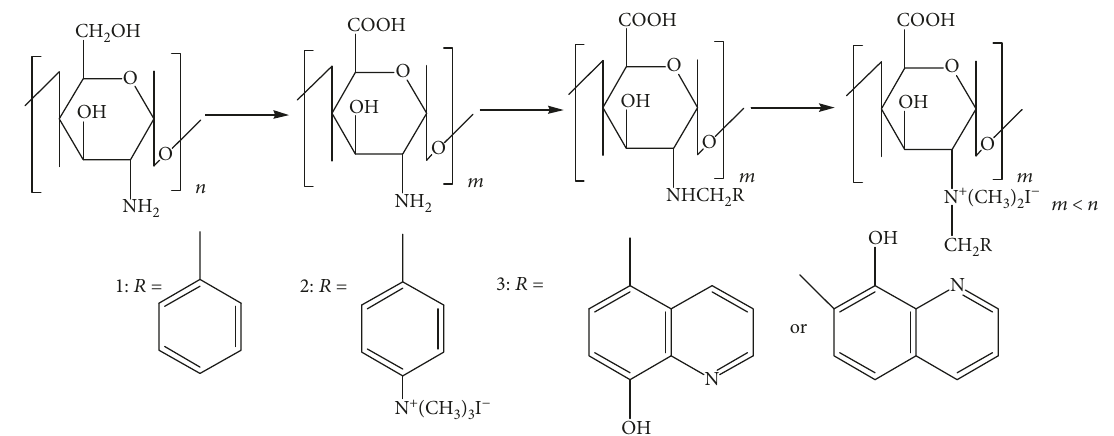
Scheme 1: Synthesis scheme for the preparation of quaternized 6-oxychitosan